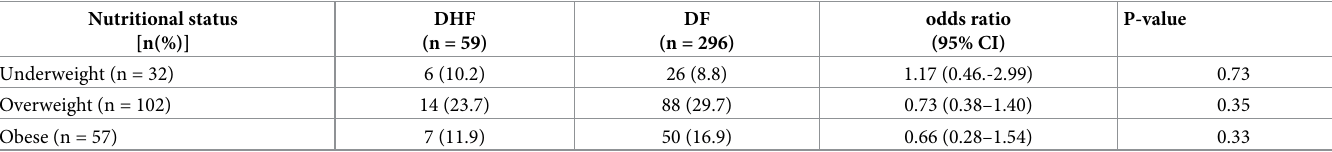
Table 4. Association between nutritional status and dengue severity according to the 1997 WHO classification. Nutritional status [n(%)]